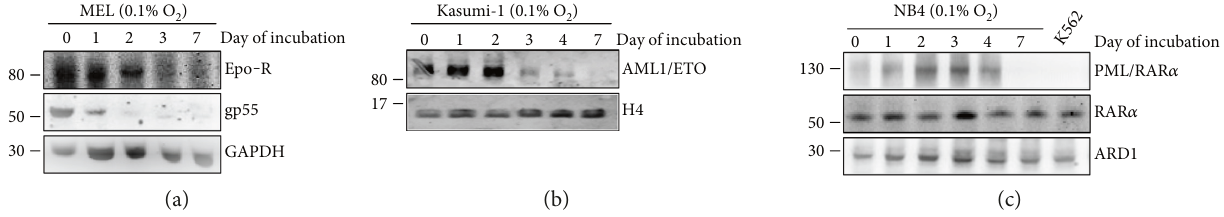
Figure 2: Suppression of oncogenic proteins driving non-CML blood neoplasias in the course of cell “ adaptation to hypoxia. ” MEL (a), Kasumi-1 (b), or NB4 (c) cells were incubated in atmosphere at 0.1% O and lysed at the indicated times, and total cell lysates were 2 subjected to immunoblotting with the indicated antibodies. GAPDH, H4, or ARD1 were detected to verify loading equalization. Migration of molecular weight markers is indicated on the left (kDa). For each cell population, one out of three independent experiments with similar outcome is shown.